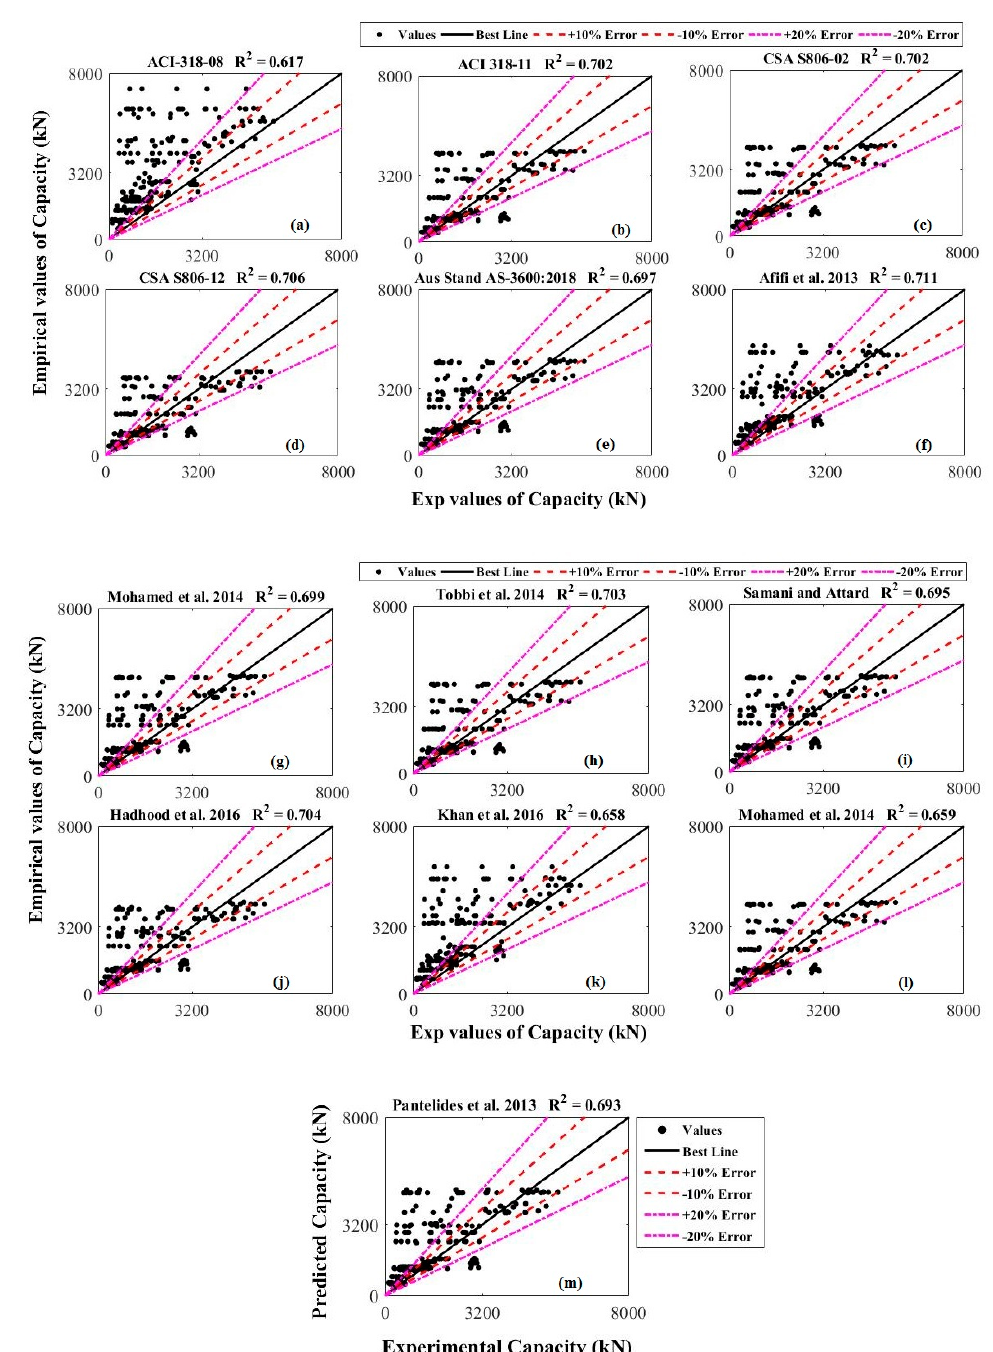
Figure 2. Performance of previous models ( a ) ACI 318-08 ( b ) ACI 318-11 ( c ) CSA S806-02 ( d ) CSA S806-12 ( e ) AS 3600-18 ( f ) Afifi et al. [23] ( g ) Mohamed et al. [32] ( h ) Tobbi et al. [48] ( i ) Samani and Attard [46] ( j ) Hadhood et al. [52] ( k ) Khan et al. [47] ( l ) Mohamed et al. [32] ( m ) Pantelides et al. [49]. In this expression, α 1 and α 2 represent the reduction coefficients for the AS of FRP- reinforced compression members due to compressive influence of FRP rebars and confined core, A FRP is the area of FRP rebars, A g is the gross area of the column, f FRP is the tensile strength of FRP rebars. In the present investigation, the curve fitting method in